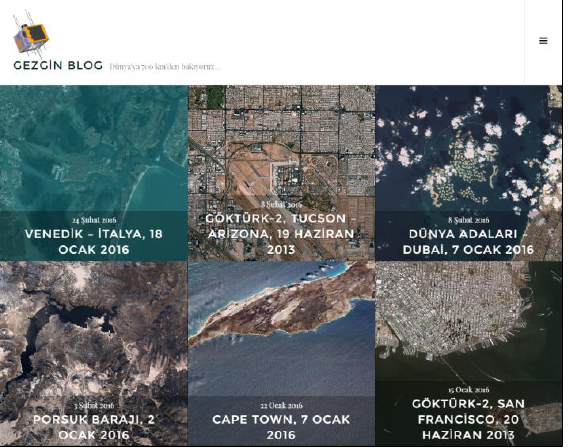
Figure 2. Sample images shared through GEZGIN Blog.